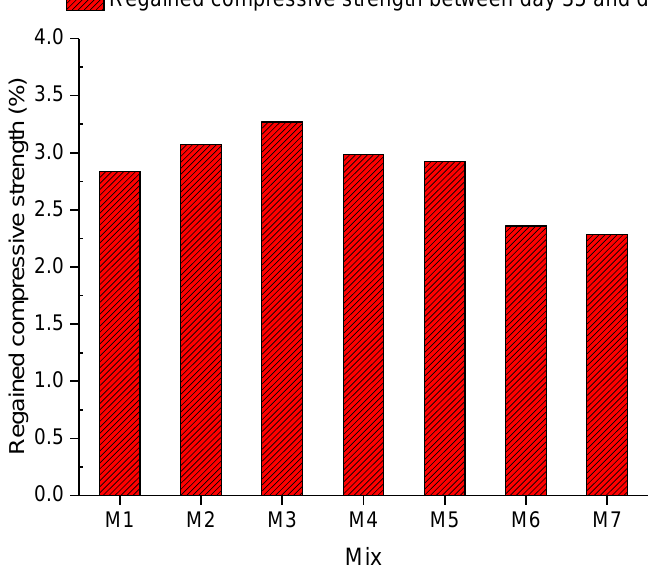
Figure 13. Regained compressive strength between day 35 and day 42.